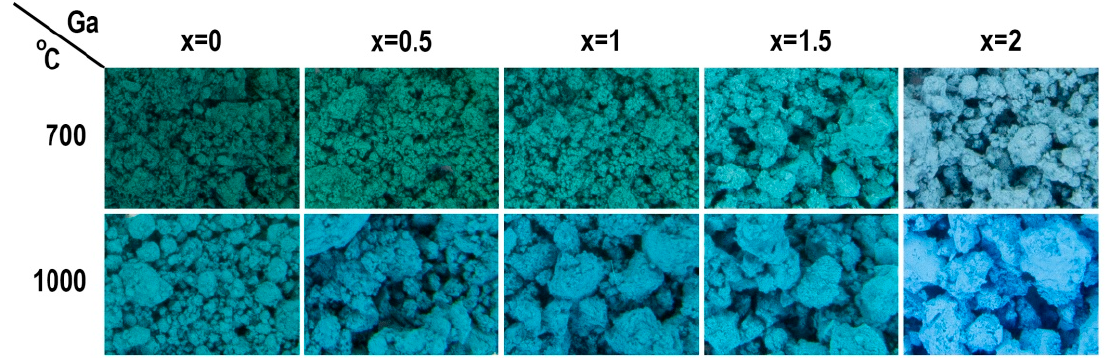
Figure 4. Digital photographs of Ga-doped cobalt chromite pigments obtained at different heating temperatures.